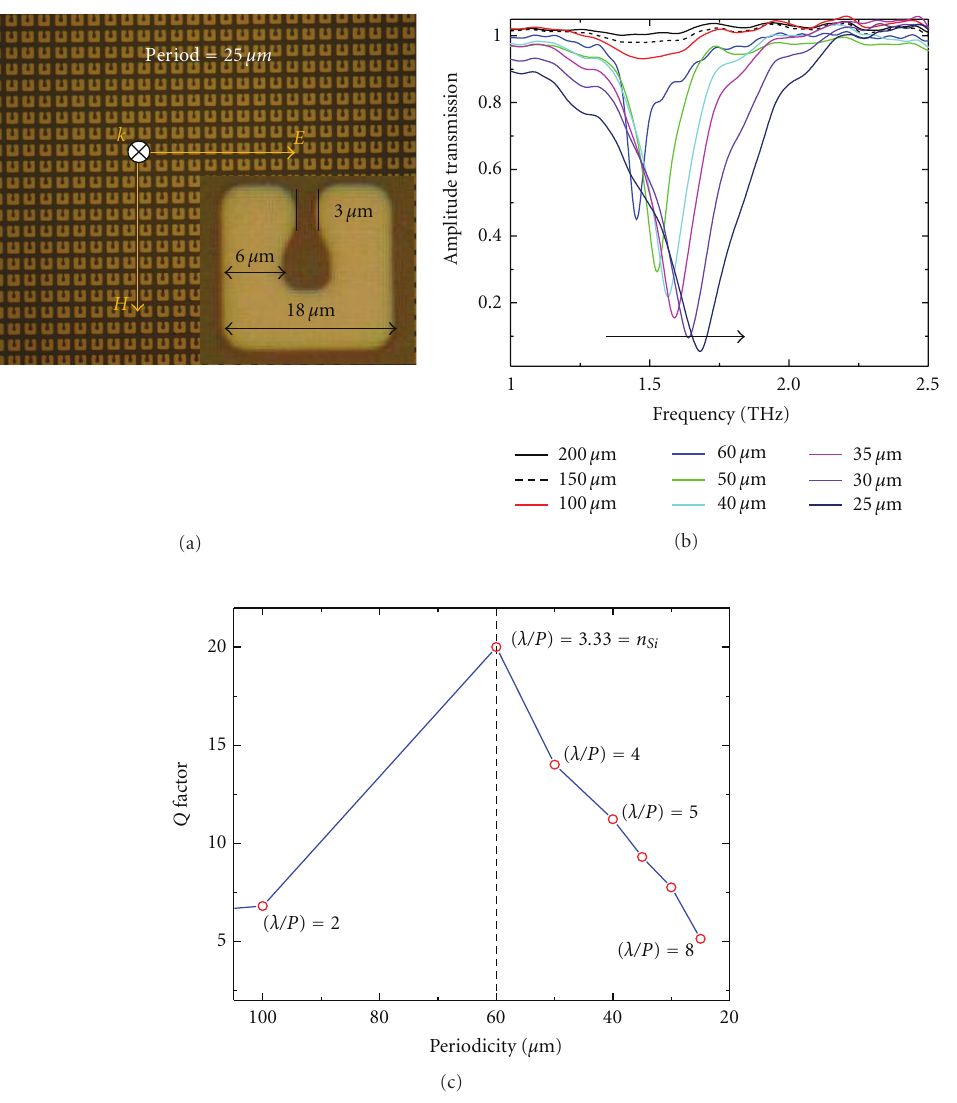
Figure 4: (a) Microscopic image of the highest-density metamaterial sample. The SRRs are comprised of 200nm thick Al on 640 μ m thick n-type silicon substrates. (b) Measured transmission spectra of metamaterials with di ff erent periodicities. (c) Quality factor extracted from the measured transmission for di ff erent period